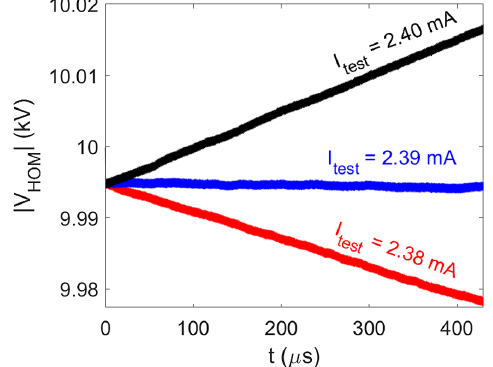
FIG. 4. HOM voltage when test current I below (red), and at (blue) the threshold current.